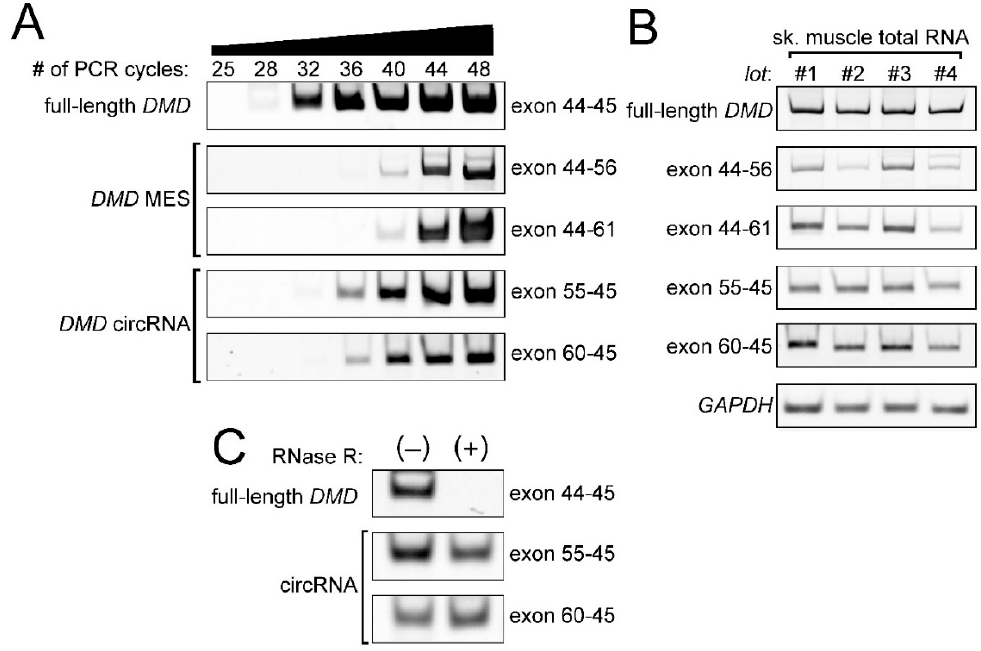
Figure 4. Expression of the exon 44–56-connected multiple exon skipping (MES) DMD mRNA. ( A ) Semiquantitative reverse transcription-polymerase chain reaction (RT-PCR) experiments for the exon 44–56 and its hypothetical by-product (exon 55–45 circRNA) were performed using human skeletal muscle total RNA. Because exon 61 frequently functioned as an acceptor of MES, the exon 44–61 and its partner (exon 60–45 circRNA) were also investigated. Total cycle numbers are shown on the upper side; ( B ) RT-PCR experiments using different total RNAs were performed. Total numbers of PCR cycles were 30 cycles for the full-length DMD mRNA, 42 cycles for the MES products (exon 44–56, 44– 61), 37 cycles for the circRNA products (exon 55–45, 60–45), and 23 cycles for GAPDH (glyceraldehyde-3-phosphate dehydrogenase); ( C ) RNase R treatment for exon 55–45 DMD